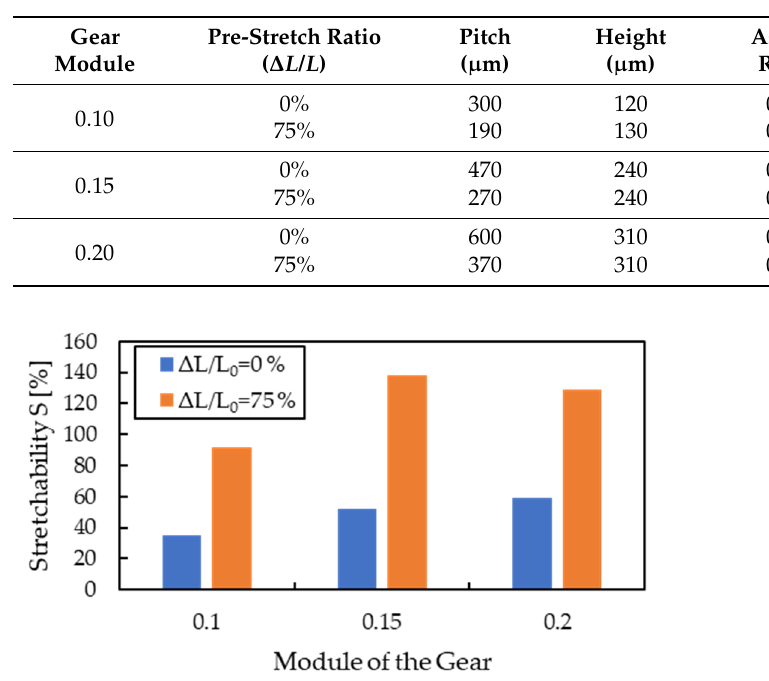
Figure 6. Prediction of stretchability based on SEM observed value in changing the gear module and with or without pre-stretch.